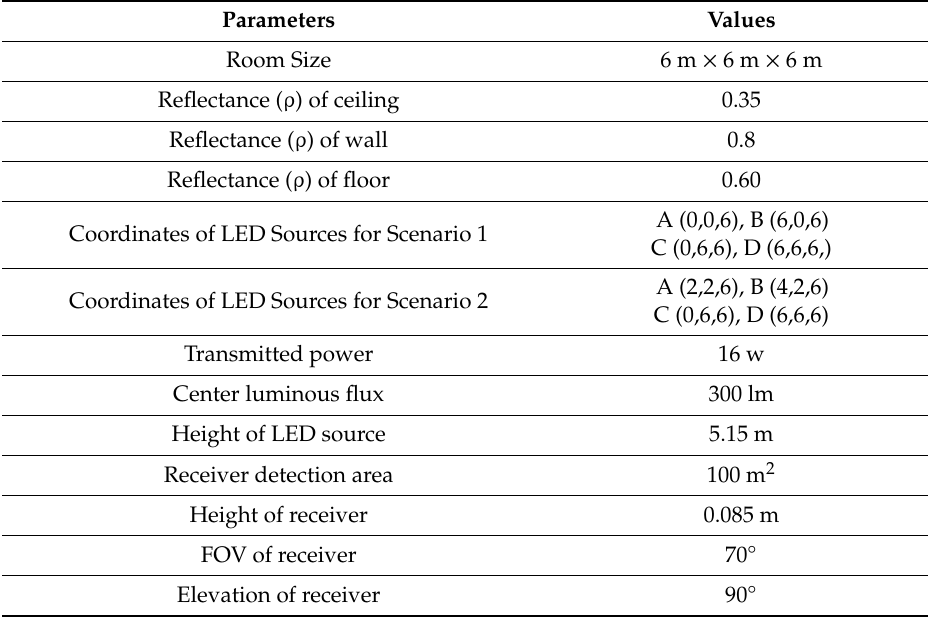
Table 1. Simulation